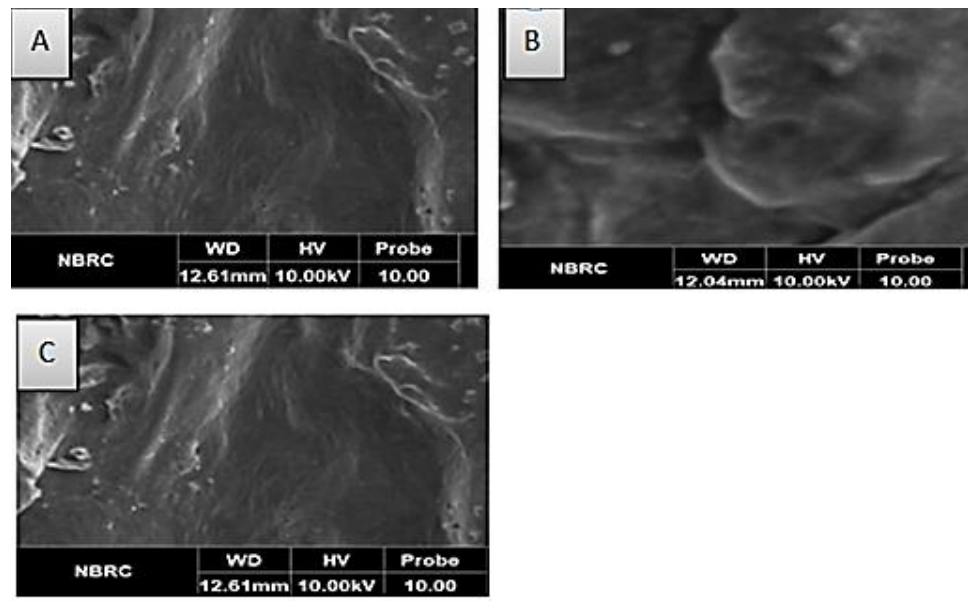
Figure 1. Scanning micrographs of encapsulated probiotics. ( A ) C ch ( L. plantarum encapsulated with chitosan). ( B ) C cl ( L. plantarum encapsulated with cellulose). ( C ) C ch-cl ( L. plantarum encapsulated with chitosan and cellulose hybrid cells).